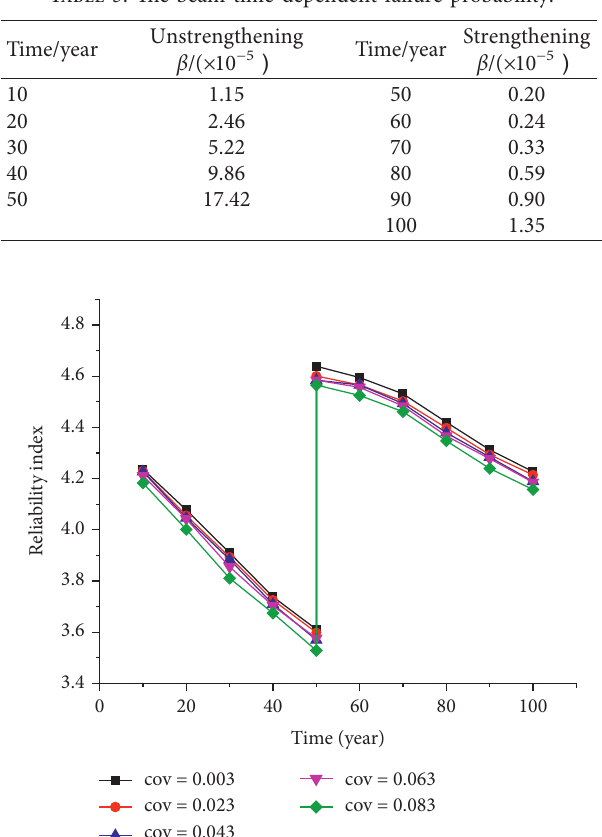
Figure 4: Influence of variation coefficients of reliability index of the dead load.